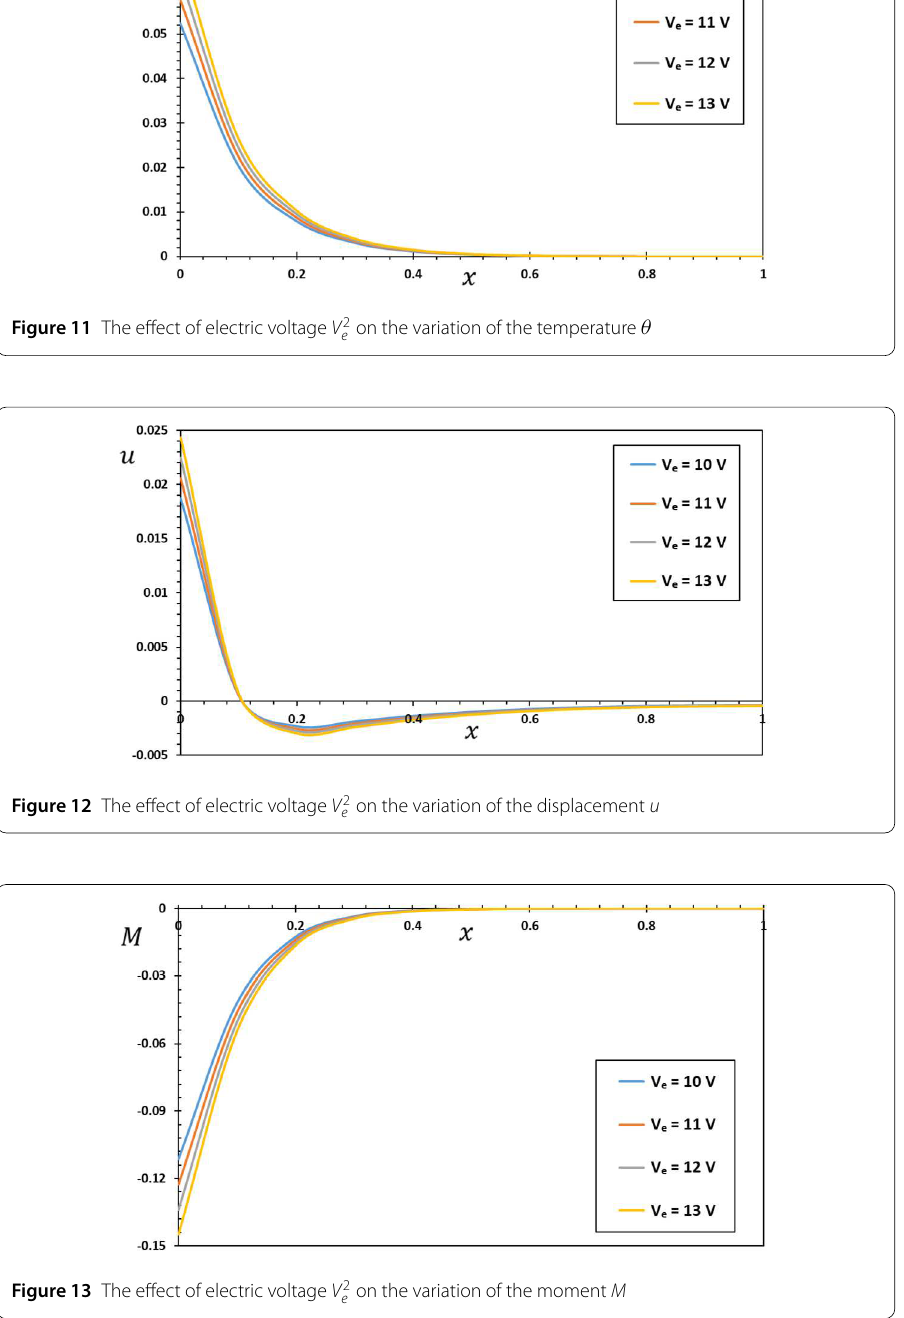
a lower resistance at higher temperatures. Figures 14 and 15 show that the value of